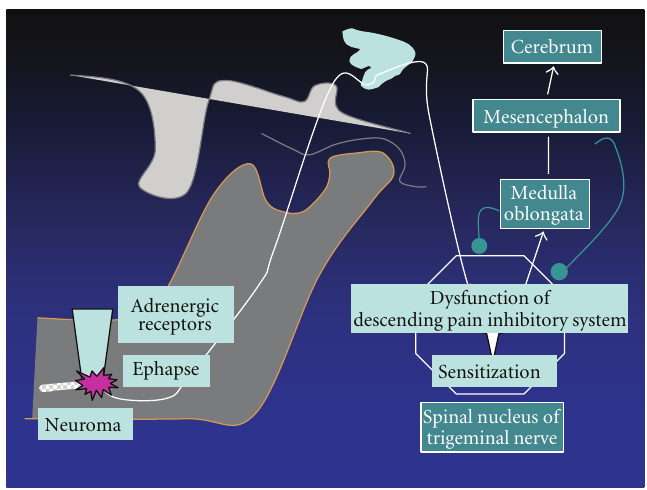
Figure 5: Pathogenic mechanism of neuropathic pain [19].